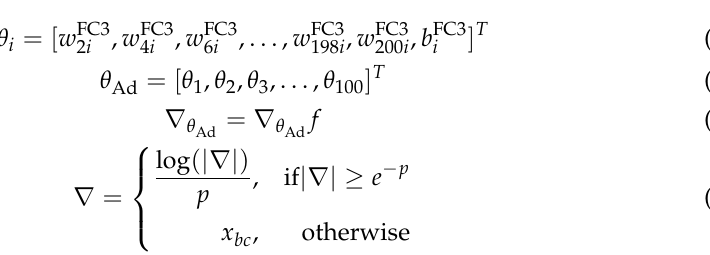
Figure 7. The architecture of adaptation